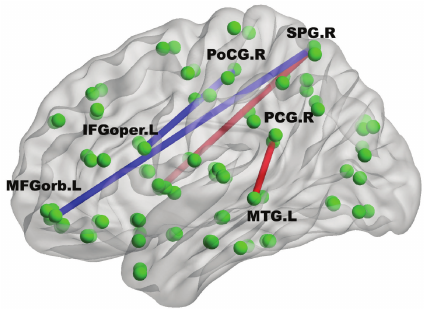
Figure 3: The 3D view for group differences after correction for multiple comparisons. While the warm color represents stronger connectivity in prelingually deaf adolescents compared to normal controls, the cold color suggests weaker connectivity.